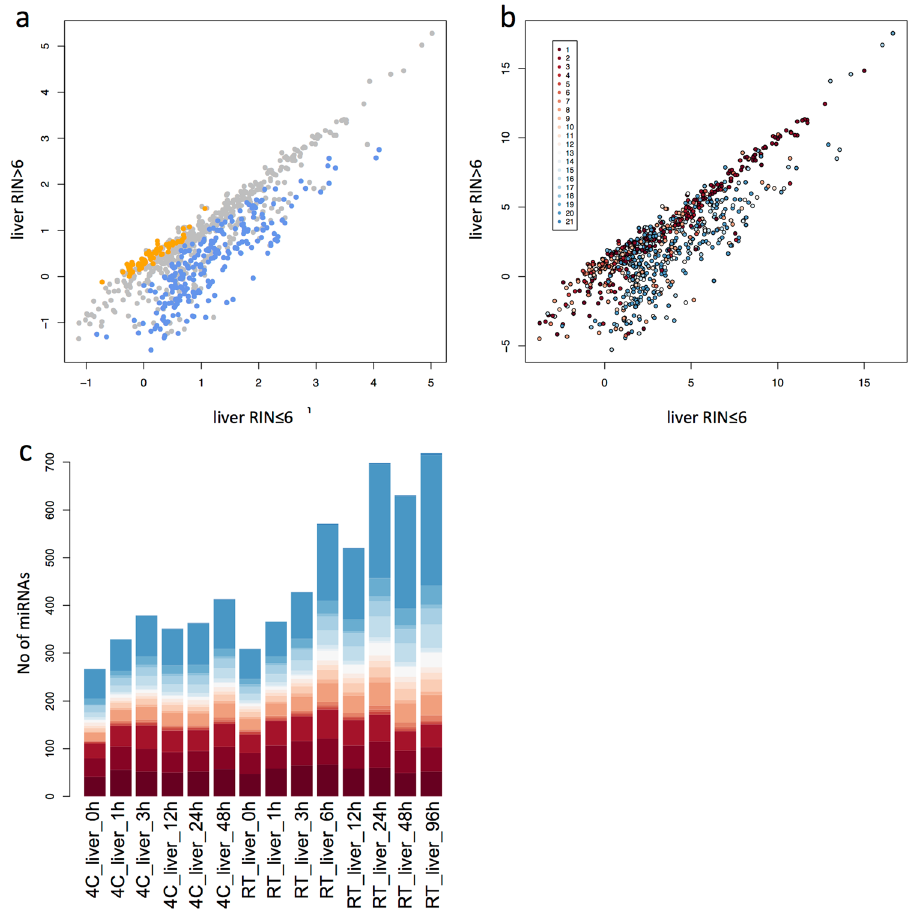
Figure 3. MiRNA expression in liver samples with low RNA quality as compared to their expression in samples of high quality. ( a ) Median expression of miRNAs in liver samples with low RNA integrity (RIN ≤ 6) are indicated on the X- axis and median expression of miRNAs with high RNA integrity (RIN > 6) on the Y-axis. Each point represents a miRNA with orange points indicating miRNAs that are significantly lower expressed in samples with low RNA integrity and with blue points indicating miRNAs that are significantly higher expressed in samples with low RNA integrity. ( b ) The same blot as in Fig. 3a, but with miRNAs color-coded according to the miRBase version, in which the miRNAs were first described. ( c ) Total number of miRNAs detected in the liver samples during the time-course experiment according to the miRBase version, in which the miRNAs were first described. Color-codes for the miRBase version as in Fig.